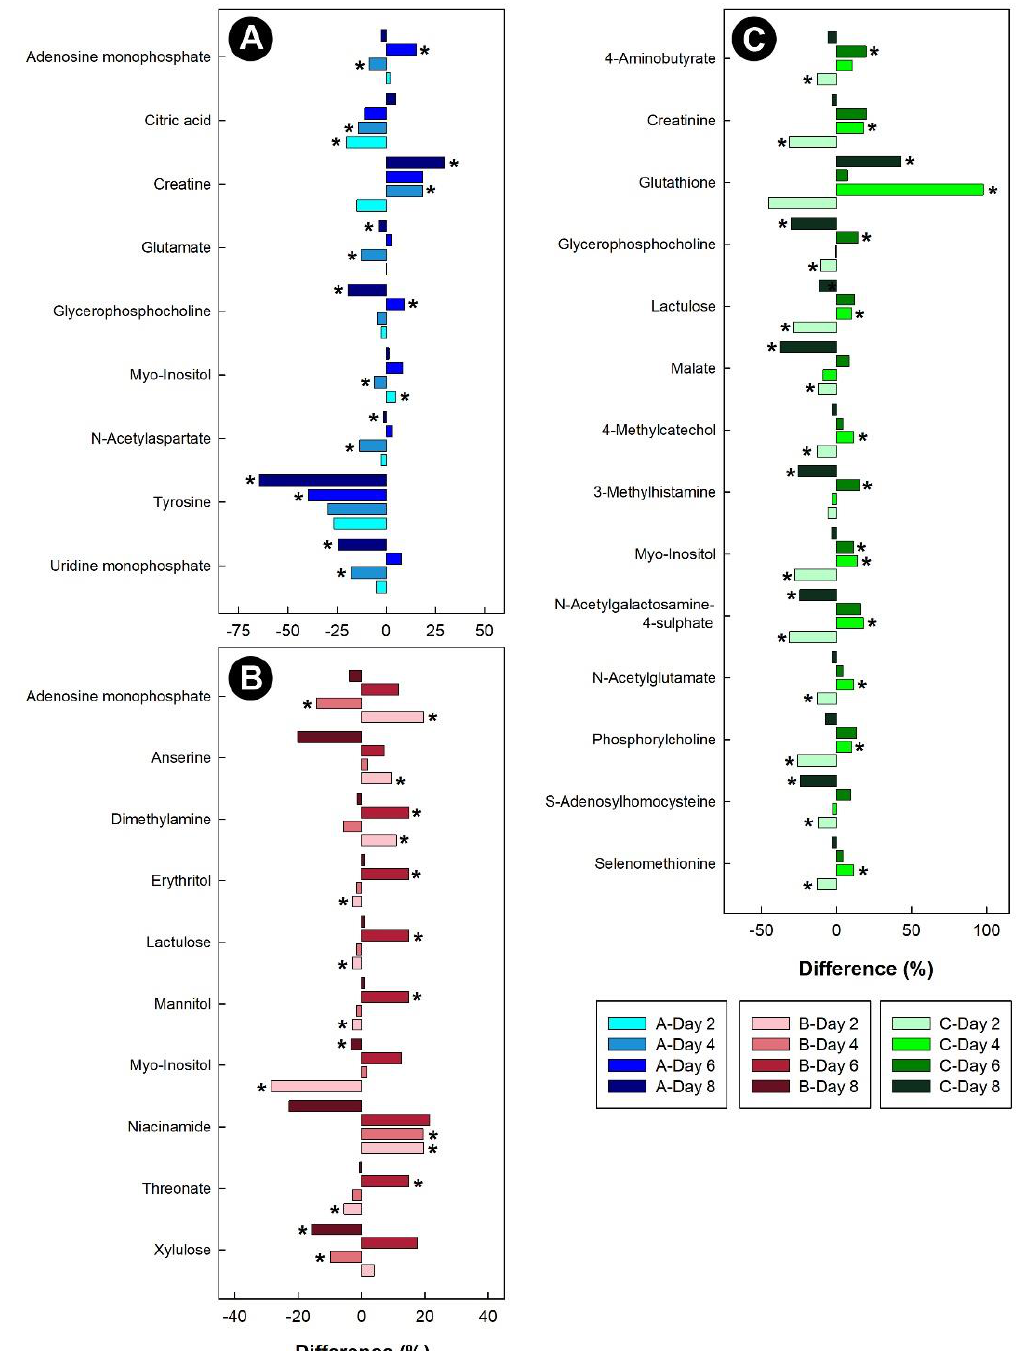
Figure 12. Regulation of common metabolites in the hippocampus of broiler chicks subjected to stressors relative to the control treatment at the four experimental endpoints. ( A ) Corticosterone (blue); ( B ) heat (red); and ( C ) isolation (green). Metabolites that were altered ( p < 0.050) are indicated by asterisks.